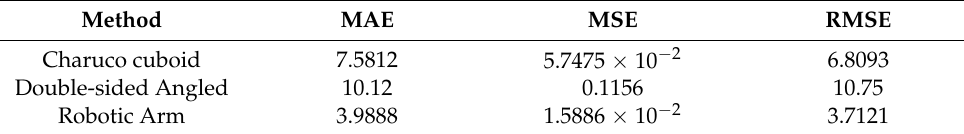
Table 1. Summary results with MAE, MSE, and RMSE for one set of data.